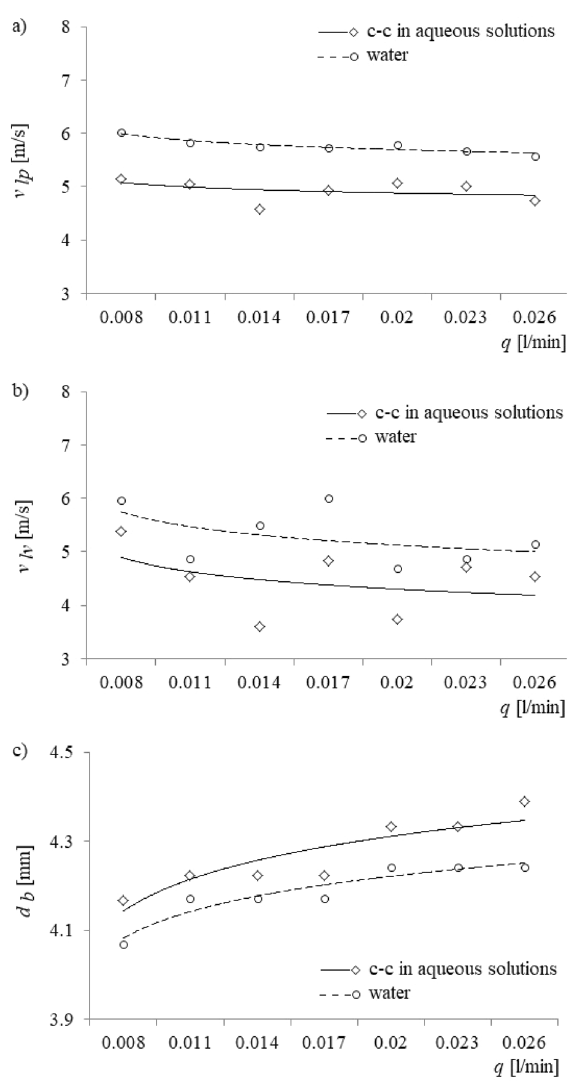
Figure 7. Bubble diameter growth, the exit velocity of liquid vapour from a capillary, and liquid penetration into the capillary vs. air volume flow rate. ( a ) The velocity of liquid vapour exiting the capillary, ( b ) the velocity of liquid penetration into the capillary, and ( c ) bubble diameter